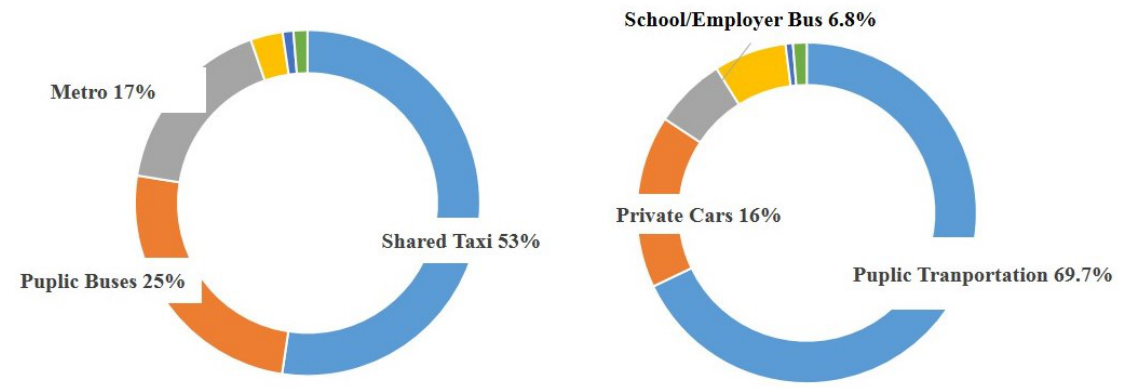
Figure 5. Trip generation pattern- source (JICA,